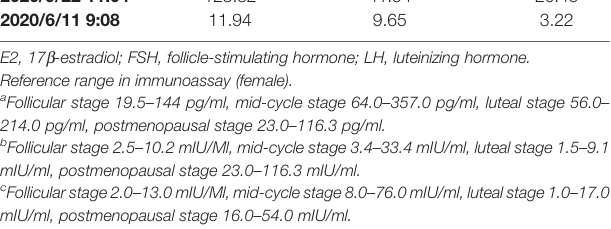
14.90 U/ml, and 6.60 U/ml, respectively ( Table 1 ). The serum levels of 17 b -estradiol (E2), follicle-stimulating hormone (FSH), and luteinizing hormone (LH) were 11.94 (pg/ml), 9.65 (mIU/ml), and 3.22 (mIU/ml) ( Table 2 ). The rest of the physical examination was also all within normal limits.